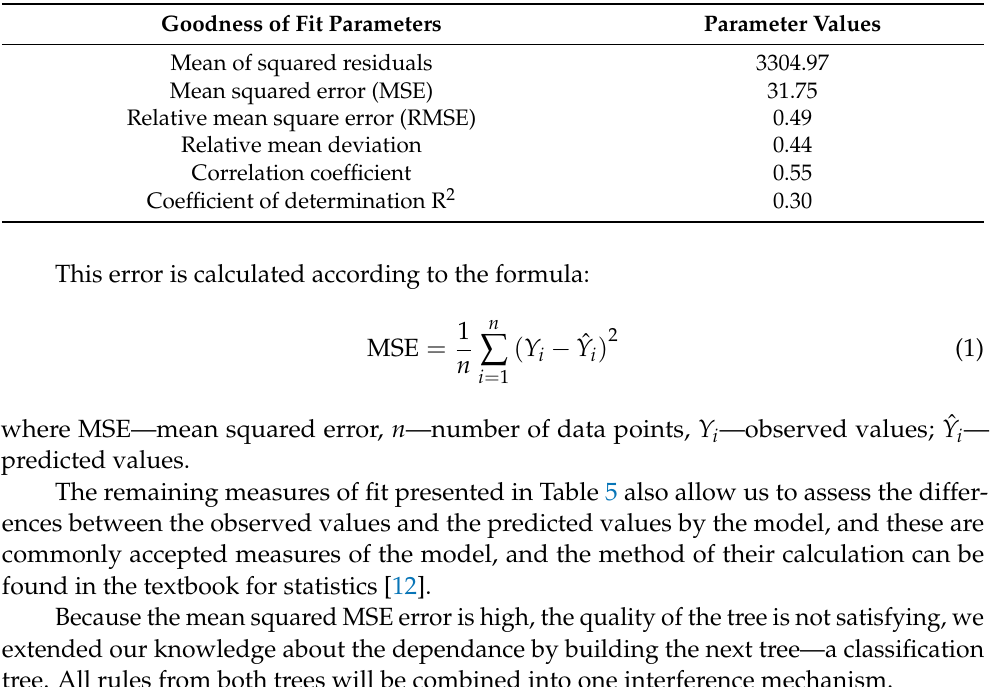
Table 5. Goodness of the fit of the tree model summary.